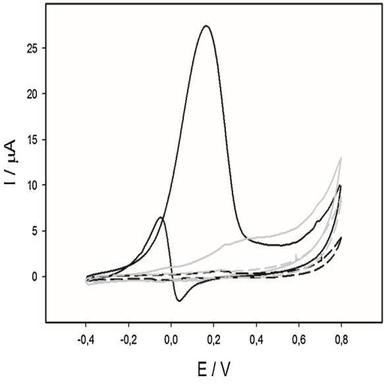
Elctrocatalytical oxidation of ethanol on filtering paper covered with PPy–Au composite. Solid black line – PPy–Au @filtering paper + 0.1 M NaOH + 0.5 M EtOH, solid grey line - PPy–Au @filtering paper + 0.1 M NaOH, black dashed line – GC electrode + 0.1 M NaOH + 0.5 M EtOH, grey dashed line - GC electrode + 0.1 M NaOH. Scan rate: 20 mV/s. Temp. 20 °C.